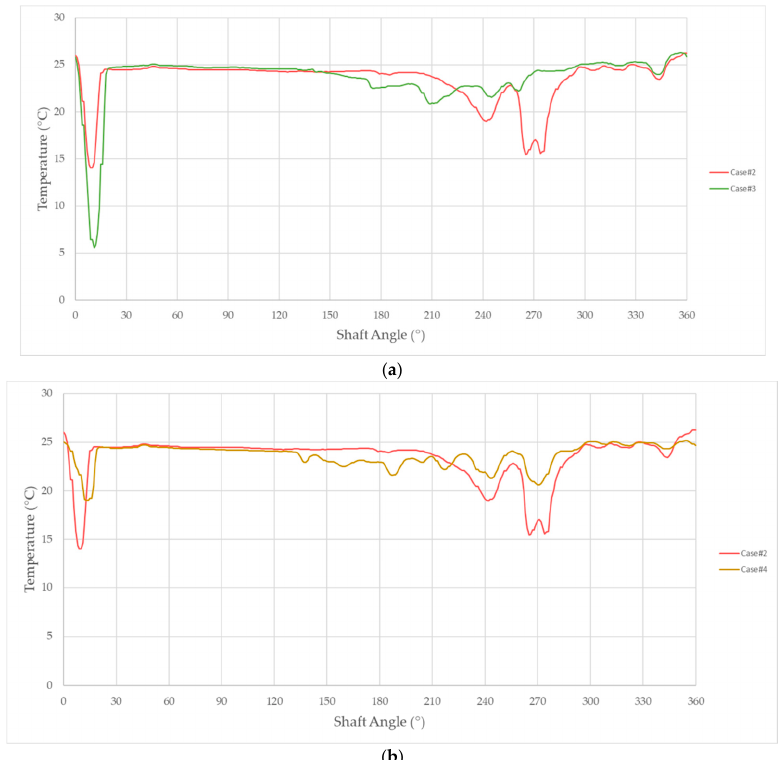
Figure 25. Temperature within the axial gap: ( a ) Case #2 and Case #3; ( b ) Case #2 and Case #4.